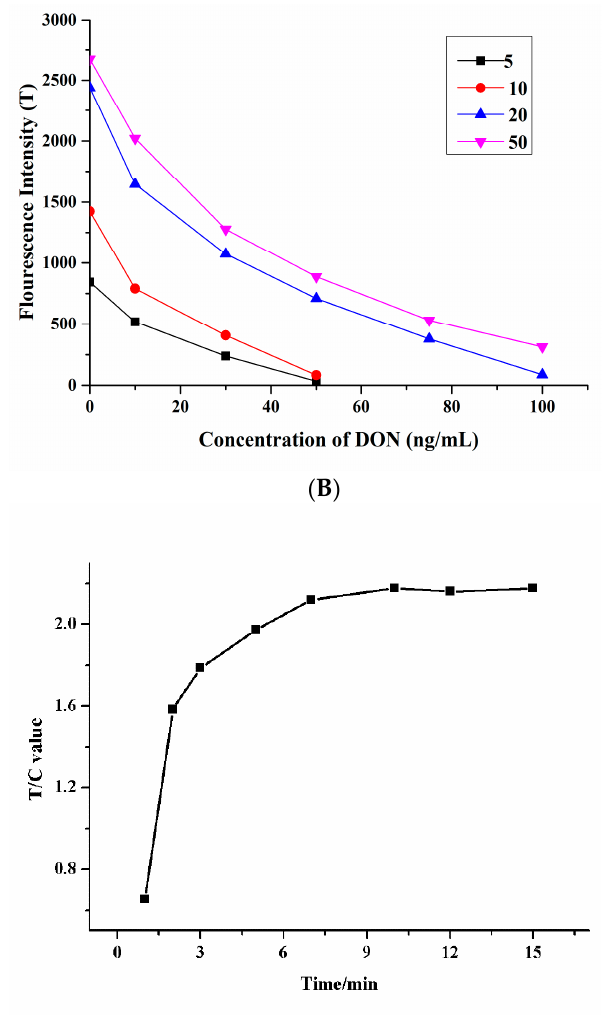
Figure 4. ( A ) Optimization of coupling amount of sheep anti-mouse IgG; ( B ) Different Deoxynivalenol antibody dosages and fluorescence intensity of line T; ( C ) Optimization of reaction time.